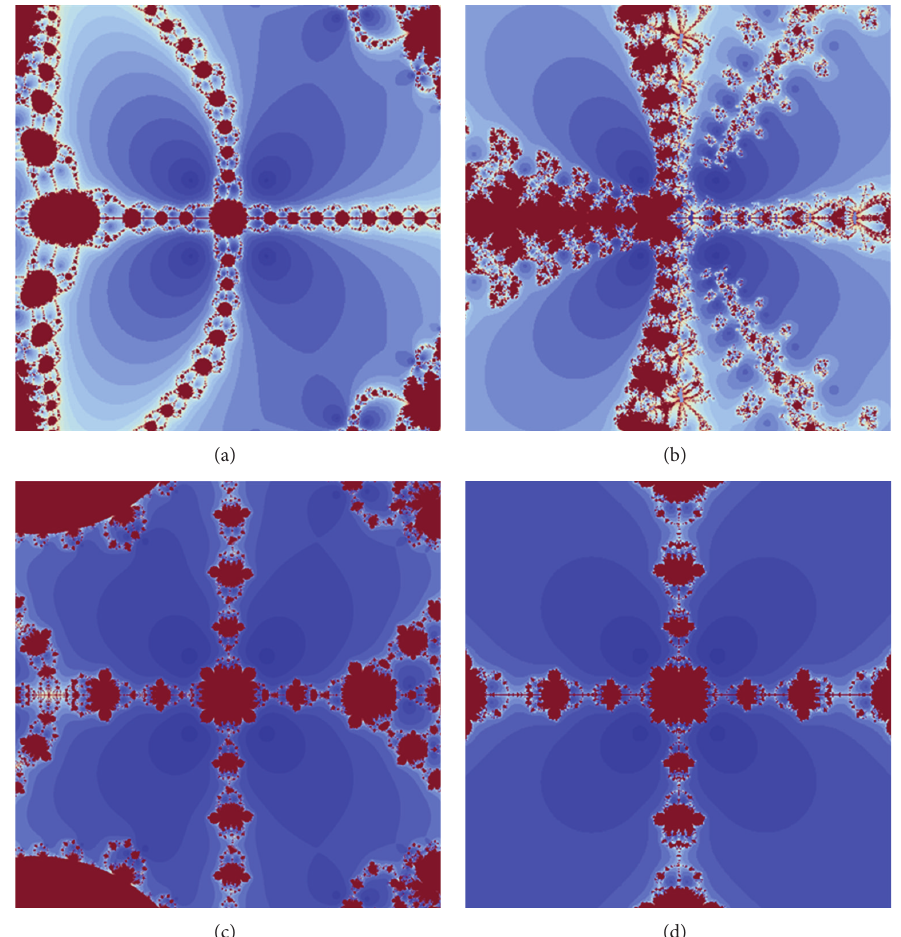
Figure 4: Fractal behavior for the rational function associated to the Steffensen’s method with 𝛽 = 0.01 (a), Jain’s method (b), (3) with 𝛽 = 0.01 (c) and (3) with 𝛽 = 0.0001 (d) for 𝑓 : 𝑧 → 𝑧 4 + 1 . Shading according to the number of iterations.